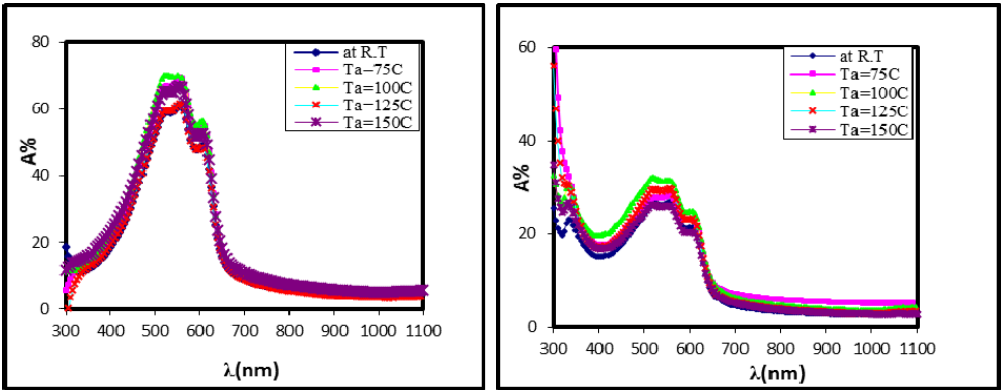
Fig. 6: The absorbance spectra of (a) P3HT and (b) P3HT:PC annealing temperatures